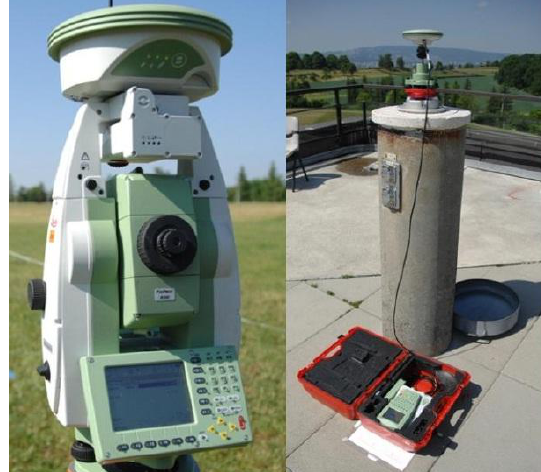
Figure 2. GPS reference station with Leica GPS1200 (right) and Leica SmartStation (left) during data acquisition.